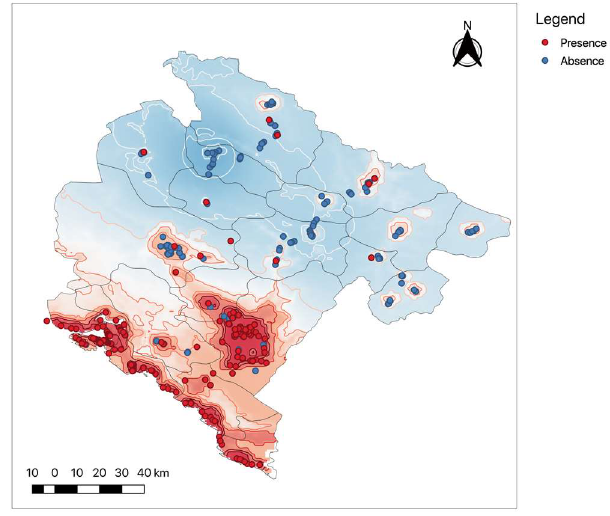
Figure 6. The observed catches of Ae. albopictus for 2001–2017.